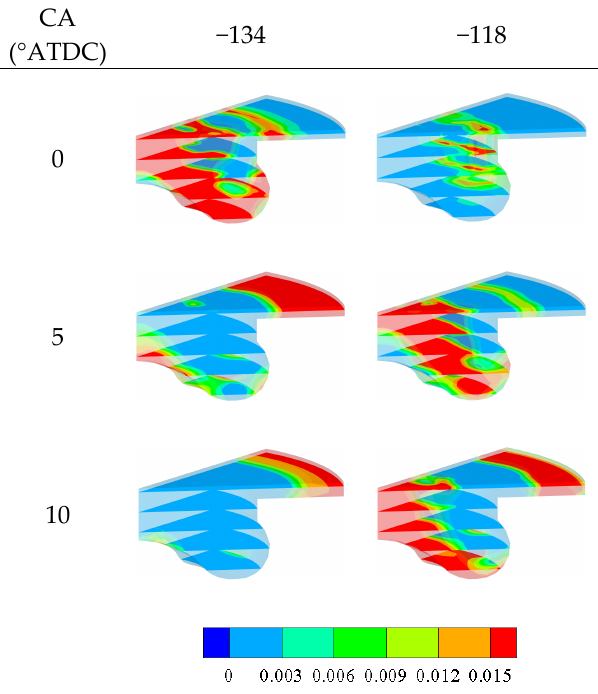
Figure 20. Simulated evolution of spatial CO distributions under conditions with IVC timings of − 134° and − 118 °ATDC.